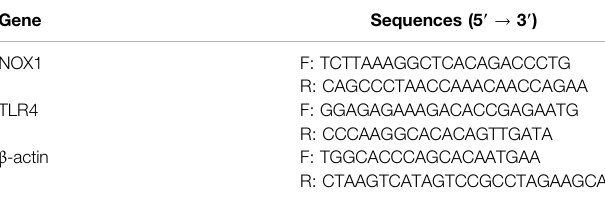
TABLE 1 | Primer sequences of NOX1, TLR4 and β -actin in this